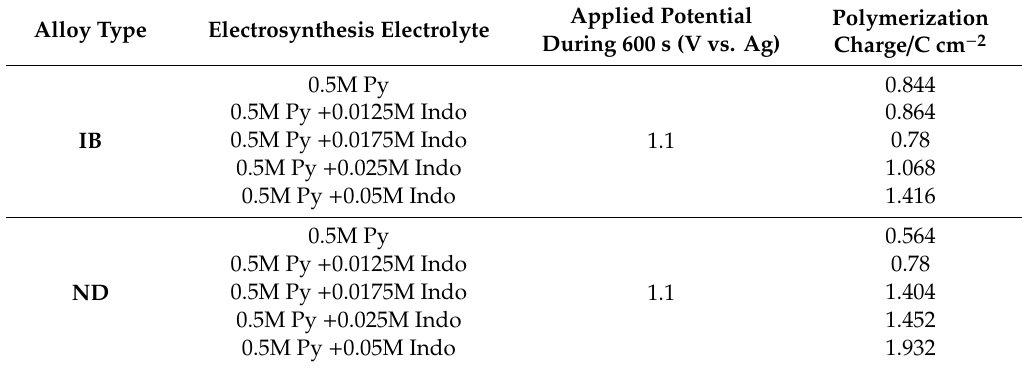
Table 2. Polymerization charge for different Indo concentrations in ILM-ACN based electrolytes. Alloy Type